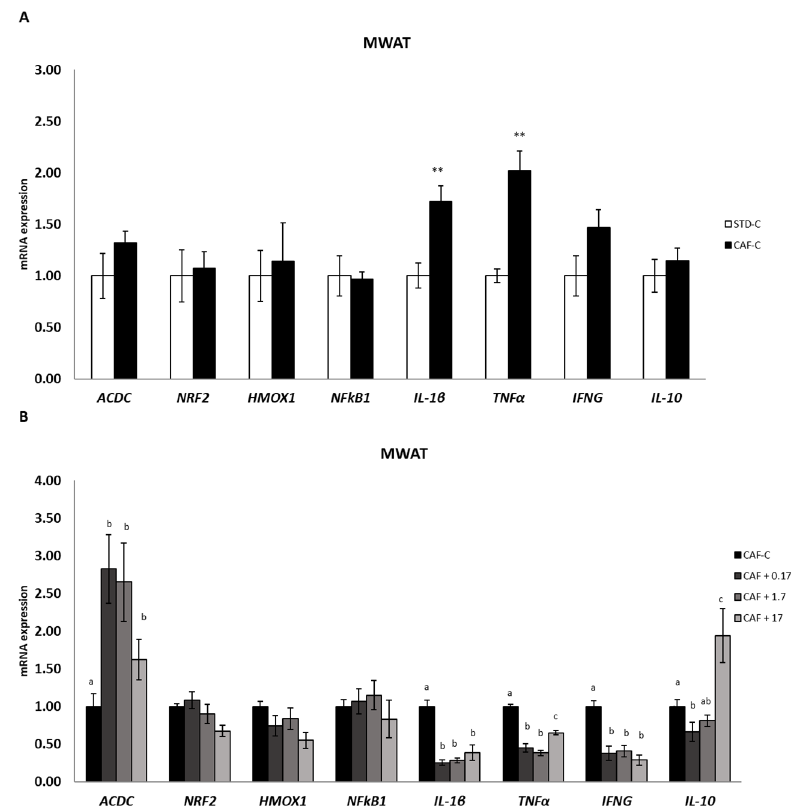
Figure 3. mRNA expression in MWAT. All values are means ± standard error of the mean (SEM). Differences between rats fed standard (STD) diet and supplemented with vehicle (STD-C, n = 8) and rats fed cafeteria (CAF) diet and supplemented with vehicle (CAF-C, n = 8) ( A ) were assessed by using Student’s t parametric test ( t test) for independent samples: **, significantly different compared to the STD-C group ( p < 0.01). Differences among CAF-C rats, rats fed CAF diet and supplemented with 0.17 mg kg − 1 body weight (bw) per day of TetraSOD ® (CAF + 0.17, n = 8), rats fed CAF diet and supplemented with 1.7 mg kg − 1 bw of TetraSOD ® (CAF + 1.7, n = 8) and rats fed CAF diet and supplemented with 17 mg kg − 1 bw of TetraSOD ® (CAF + 17, n = 8) ( B ) were evaluated by the ANCOVA test, using the percentage of body fat in the 8th week (before treatment) as a covariable: abc letters indicate statistically significant differences among the CAF groups ( p < 0.05). ACDC, adiponectin; HMOX1, heme oxygenase 1; IFNG, interferon gamma; IL-1 β ; interleukin 1 beta; IL-10; interleukin 10; NF κ B1, nuclear factor kappa B subunit 1; NRF2, nuclear factor, erythroid 2-like 2; TNF α , tumour necrosis factor